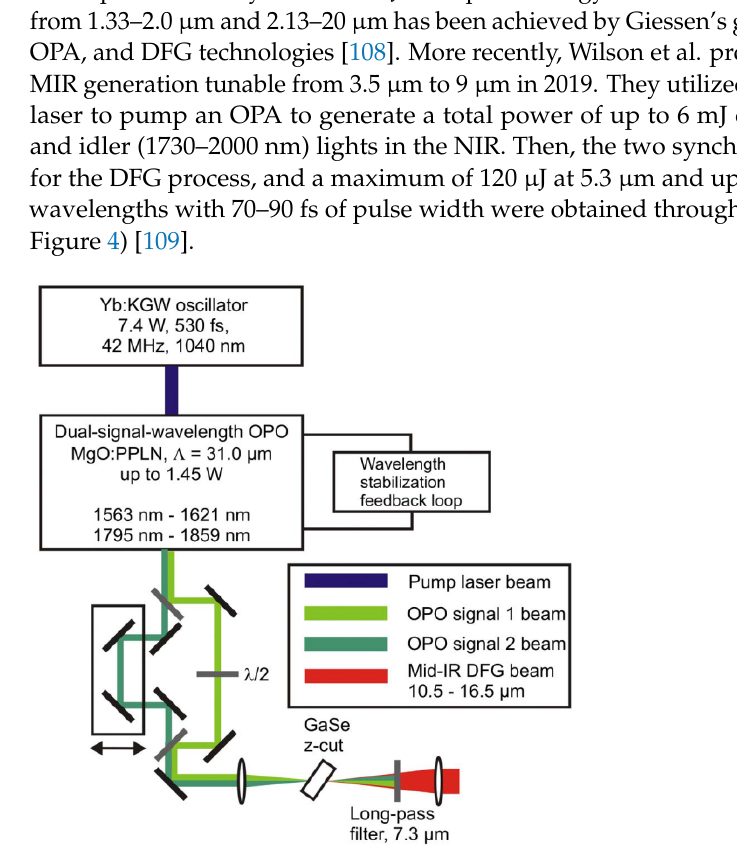
Figure 3. A 10.5–16.5 µm tunable femtosecond MIR pulsed laser system. Reprinted with permission from [107] © The Optical Society. Here, a 1 mm long MgO-doped periodically poled lithium niobate (PPLN) crystal is used for the dual-signal-wavelength OPO working at room temperature, which is synchronously pumped by a 1040 nm, 7.4 W, and 530 fs Yb: KGW oscillator at 42 MHz repetition rate. The dual-wavelength output beams of the OPO are focused on the GaSe crystal for DFG-based MIR generation.